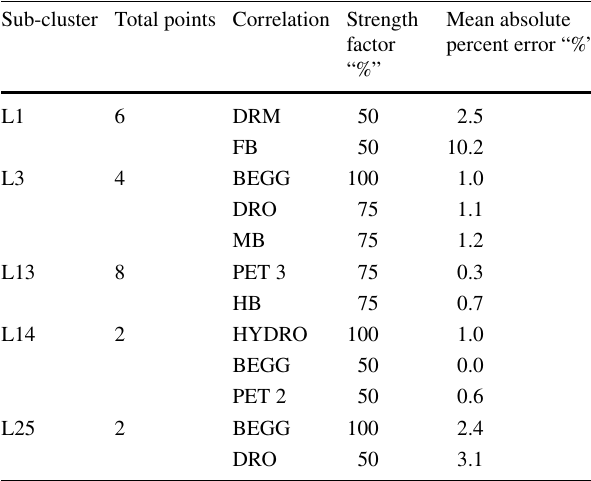
Table 20 Best correlations for cluster (L) Sub-cluster Total points Correlation Strength